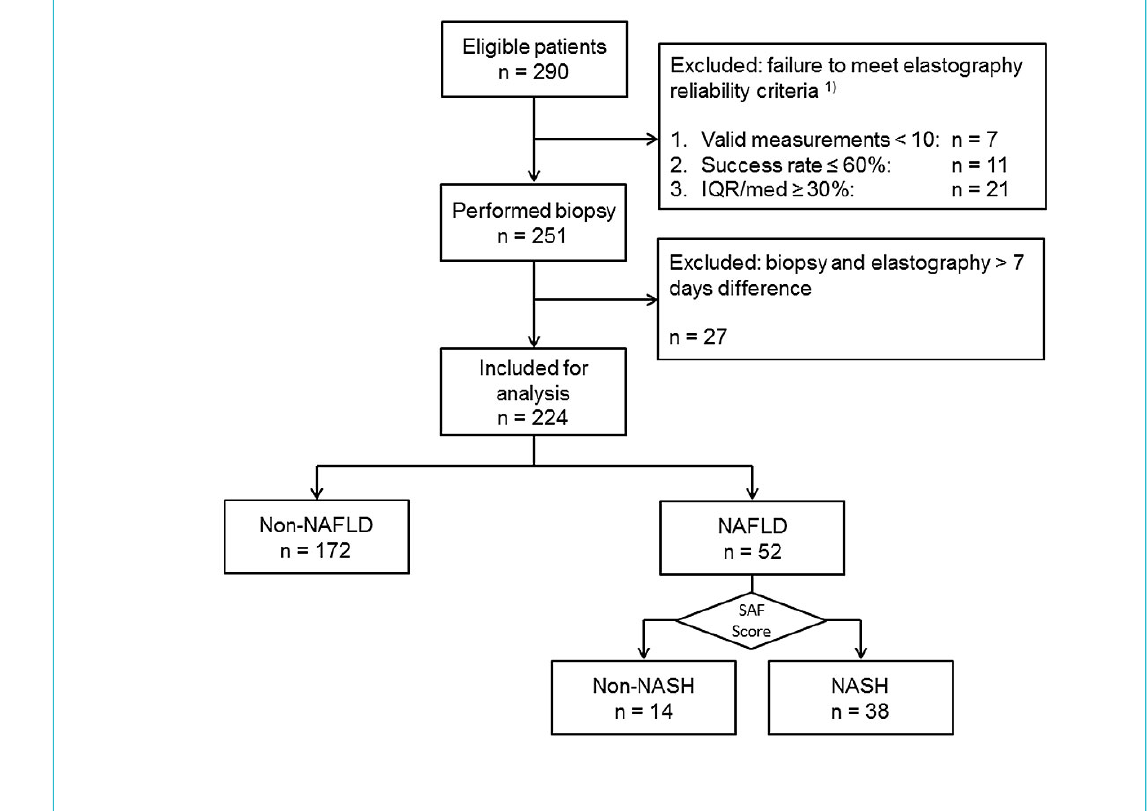
Figure 1: STARD flow diagram. 1) A total of 39 patients were excluded because of unreliable measurements. Among them 21 (54%) suffered from non-alcoholic fatty liver disease (NAFLD). IQR/med = interquartile range / median; NASH = non-alcoholic